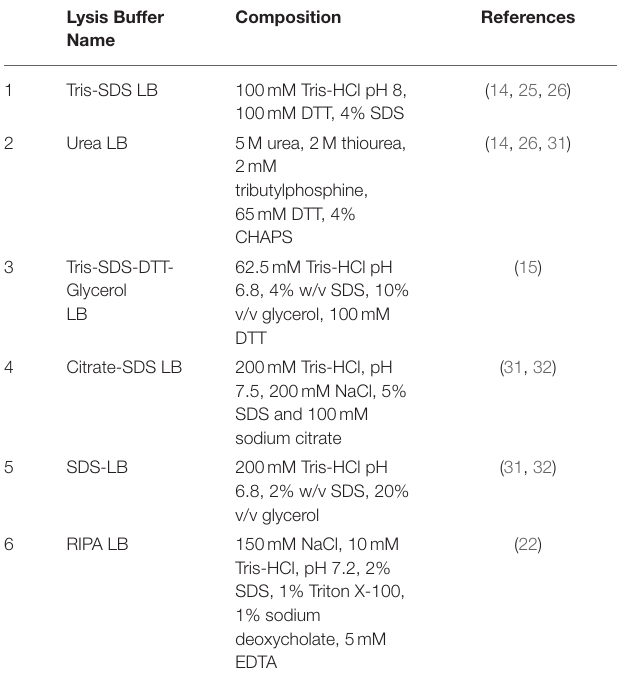
TABLE 2 | Composition of the different protein extraction buffers reported in the literature that were used in the present work.